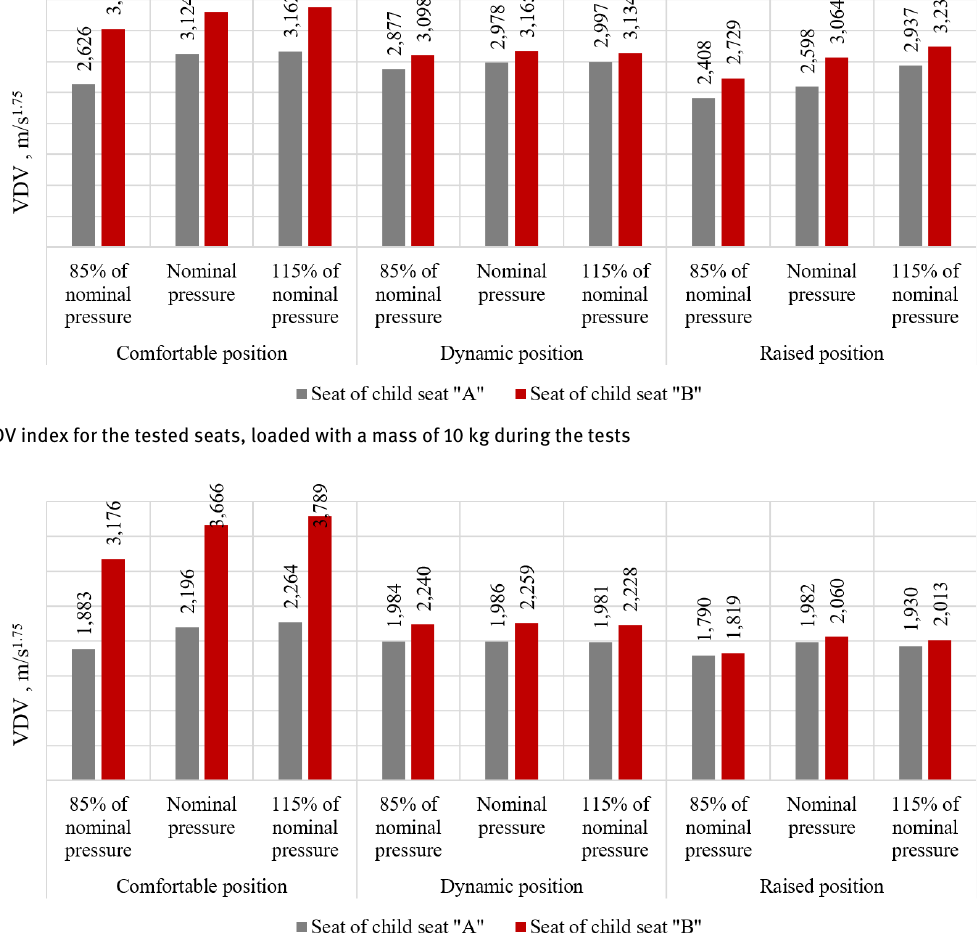
Figure 15: VDV index for the tested seats, which were loaded with a mass of 12.5 kg during the tests